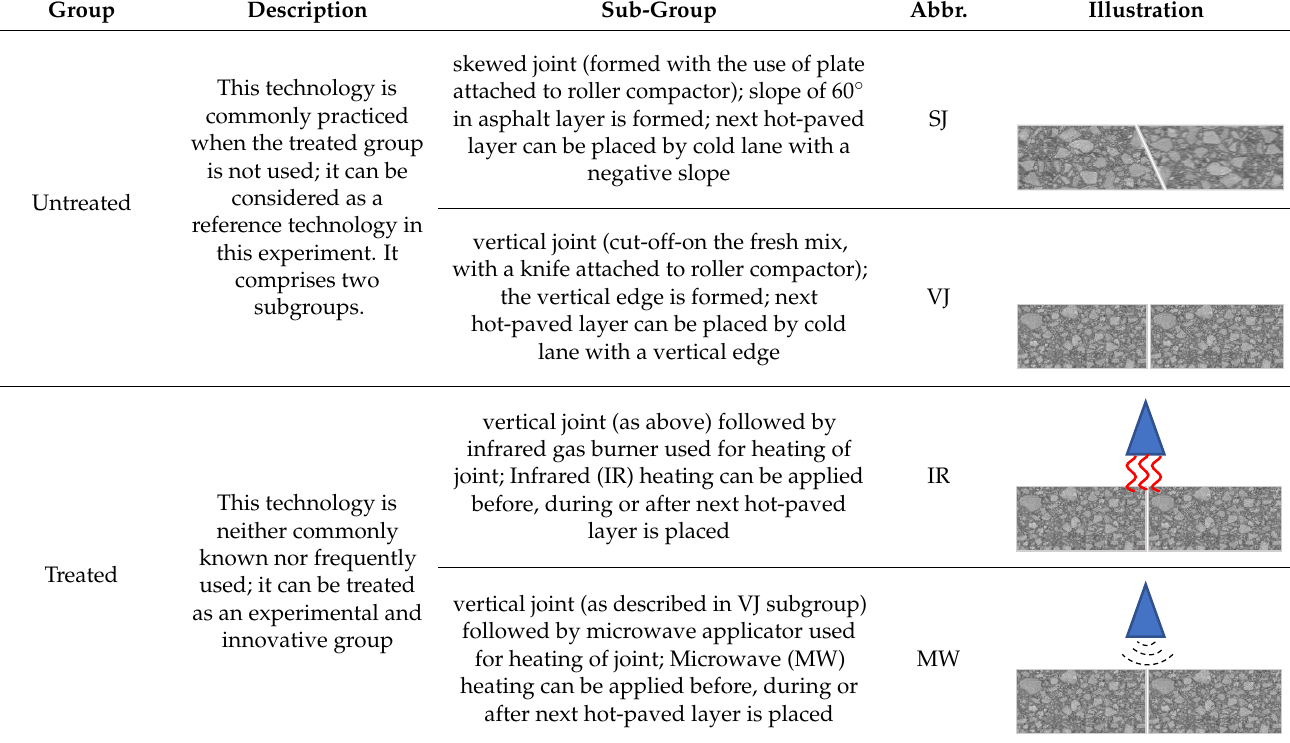
Figure 2. The schematic longitudinal cross-section of the longitudinal joints construction test section. Table 2. Evaluated joint construction technologies and crack repair. Abbr. Illustration